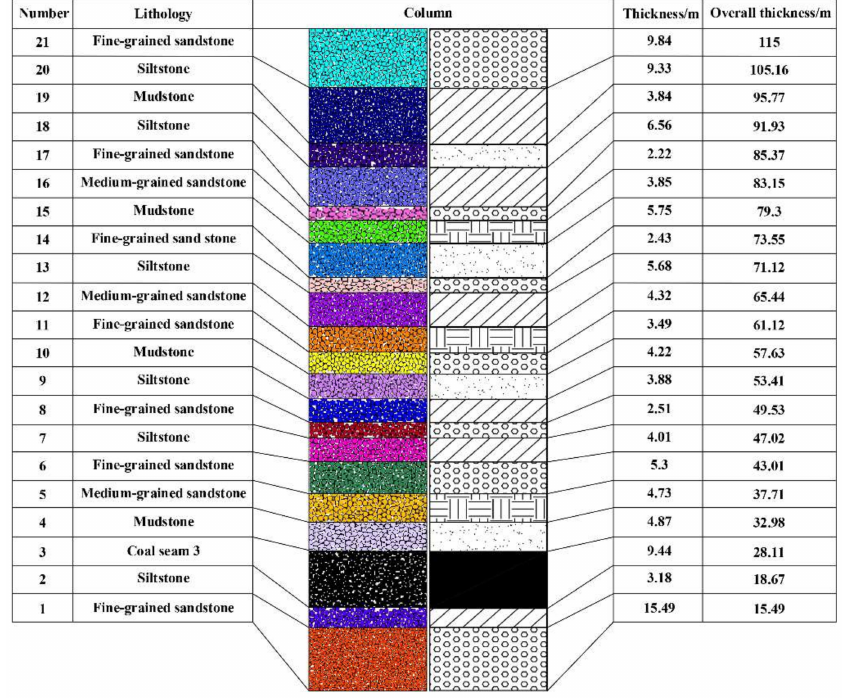
Figure 4. Typical geological log profile of No. 6306 Face and its overlying and underlying